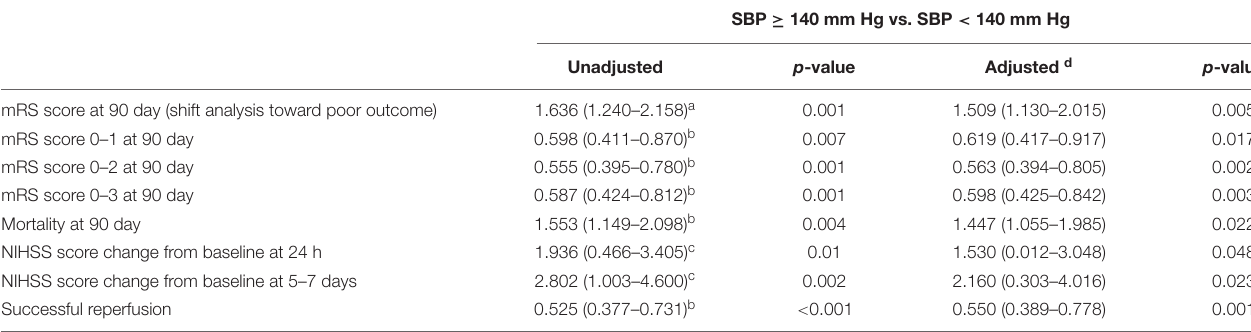
TABLE 3 | Association of baseline SBP with clinical and radiographic outcomes in univariable and multivariable